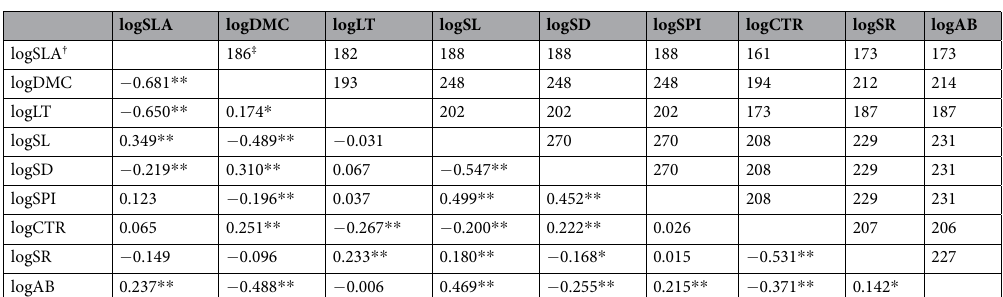
Table 2. Pearson’s correlation of leaf traits. † DMC, dry matter content; SLA, specific leaf area; LT, leaf thickness; SL, stomatal pore length; SD, stomatal density; SPI, stomatal pore index; CTR, cell tense ratio; SR, spongy tissue ratio; AB, abaxial cell thickness. ‡ The numbers of samples are shown in the upper right section of the matrix. The correlation coefficients (r) are shown in the lower left section of the matrix. * P < 0.05; ** P <